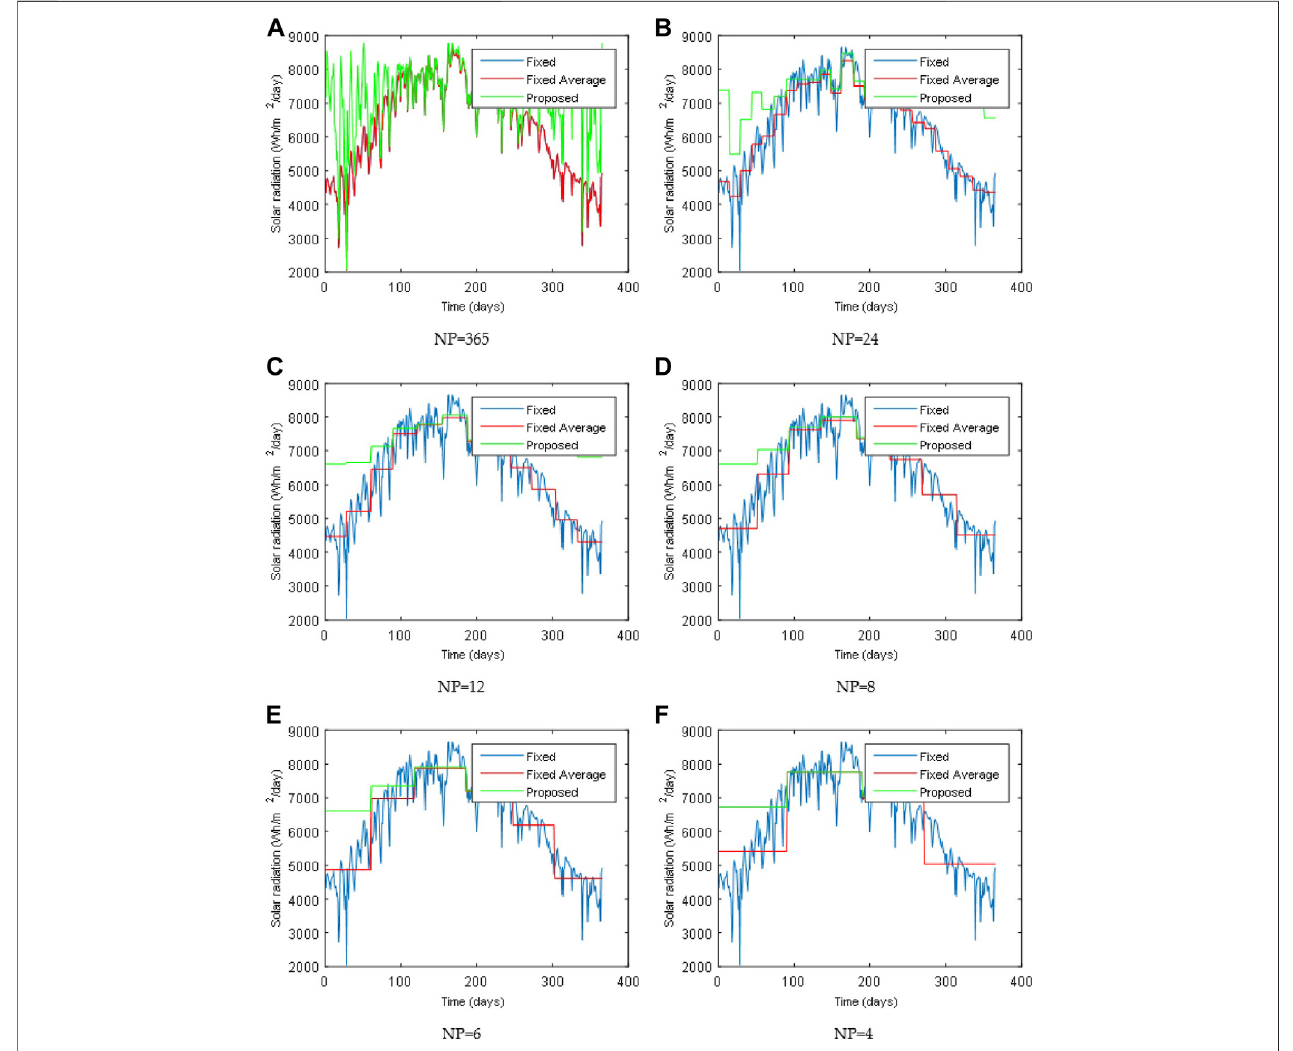
FIGURE 4 | Comparison between the total radiations on a horizontal surface and an optimally tilted surface for different NPs.